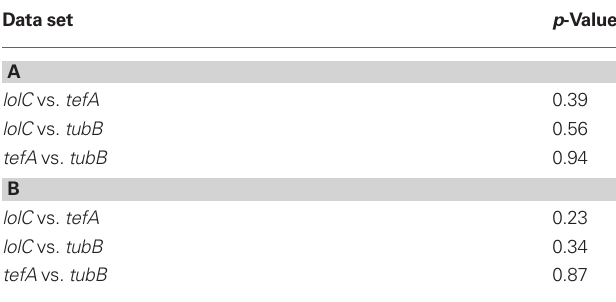
Table 3 | (a) The results with our statistical method with the endophyte data sets from lolC, tubB, tefA genes. There are 17 taxa in each data set. (B) The results with our statistical method with the endophyte data sets from lolC, tubB, tefA genes after removing E2368. There are 16 taxa in each data